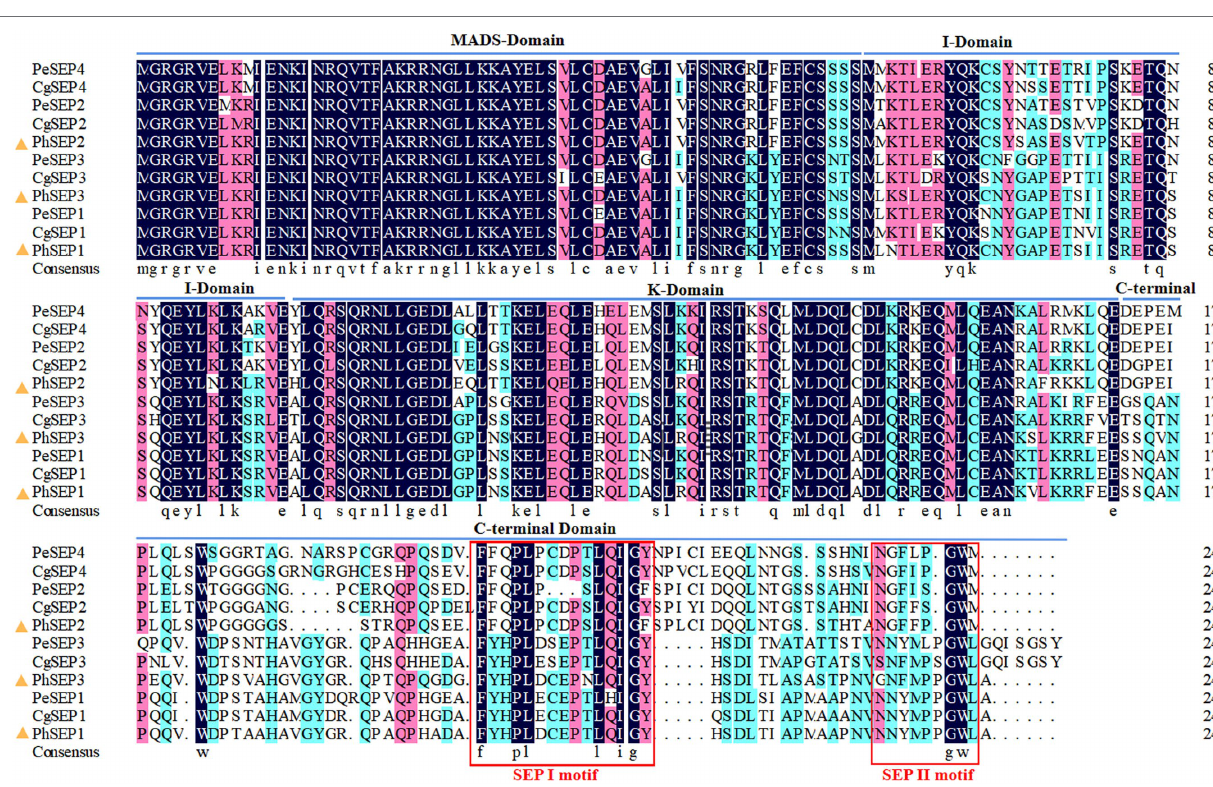
FIGURE 2 | Amino acid sequence alignment of PhSEPs and closely related homologs in orchids using the MEGA11 and DNAMAN version 4.0. The PhSEP1/2/3 proteins of P. henryanum are highlighted by yellow